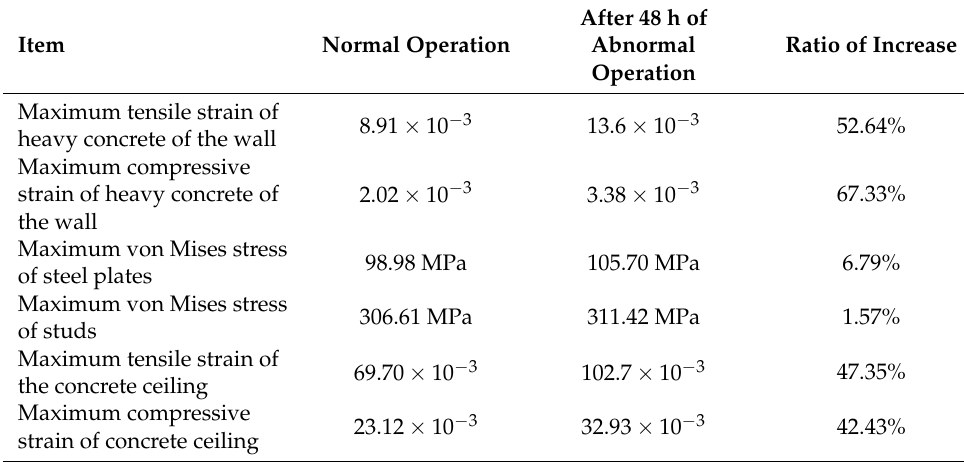
Table 3. Temperature stress and strain of the TPC under abnormal